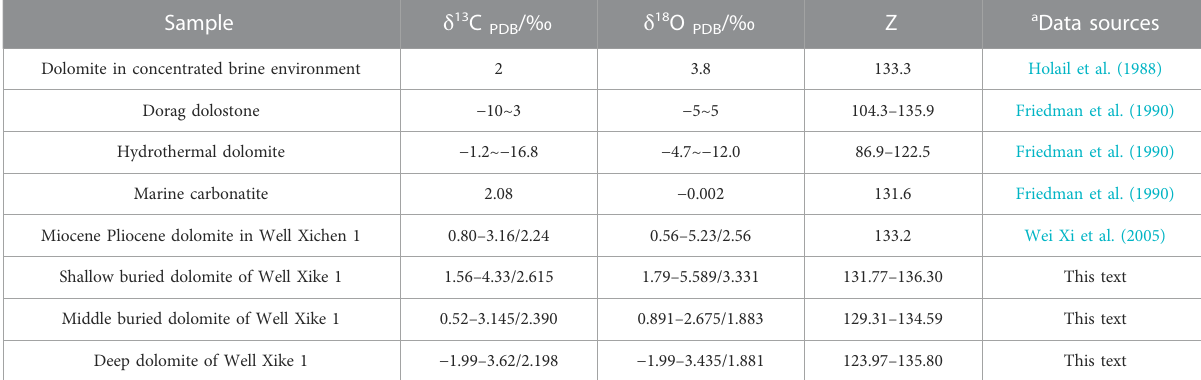
TABLE 5 Dolomites of different genesis and δ 13 C, δ 18 O and Z value of shallow, middle and deep dolomites of Well Xike 1.